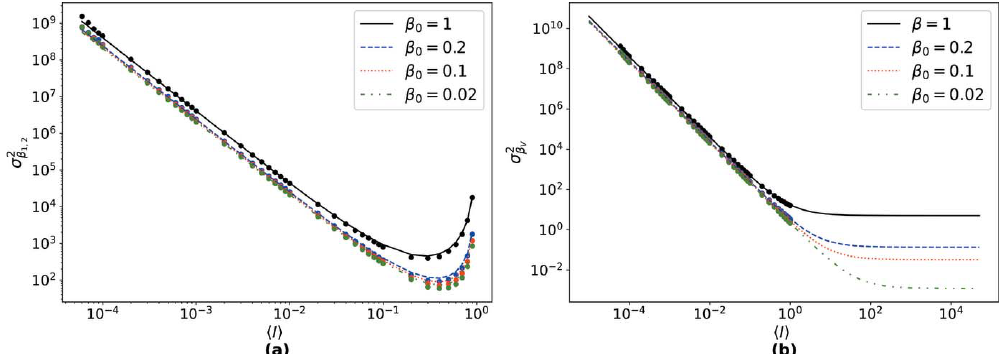
Figure 4 ( a ) Variance of (cid:6) 1,2 as a function of h I i as computed using equation (12) (solid lines) and simulated values (dots). The variance decreases with increasing h I i for low signals and then increases again as h I i approaches 1. ( b ) Variance of (cid:6) h I i as computed using equation (13) (solid lines) and V as a function of simulated values (dots). Note that (cid:8) 2 saturates at high h I i . (cid:6) V